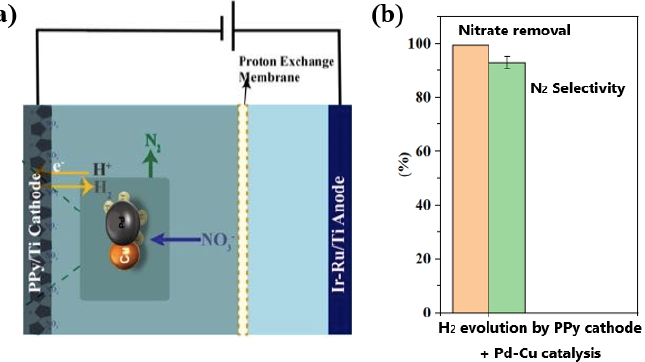
Figure 11. ( a ) Schematic diagram of H 2 evolution in combination with Pd-Cu catalysis for nitrate removal in cathodic cell, ( b ) nitrate removal, and N 2 selectivity in H 2 evolution series Pd-Cu catalytic nitrate reduction system. (Reprinted/adapted with permission from Ref. [107]. 2019, American Chemical Society.)